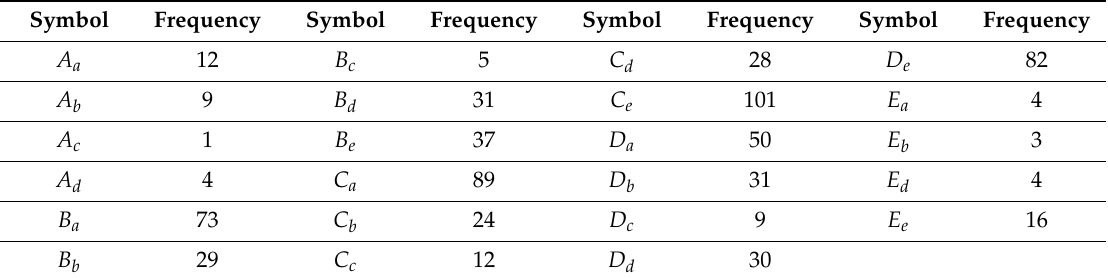
Table 7. The TFSAX representation of the monthly average water level of the Xingzi station.